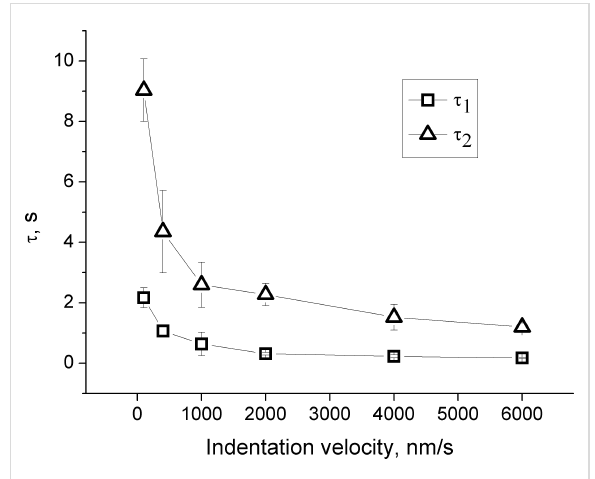
Figure 10: The cantilever’s stress relaxation time τ 1 and τ 2 as a func- tion of the initial indentation velocity. Error bars indicate the standard deviation from 10